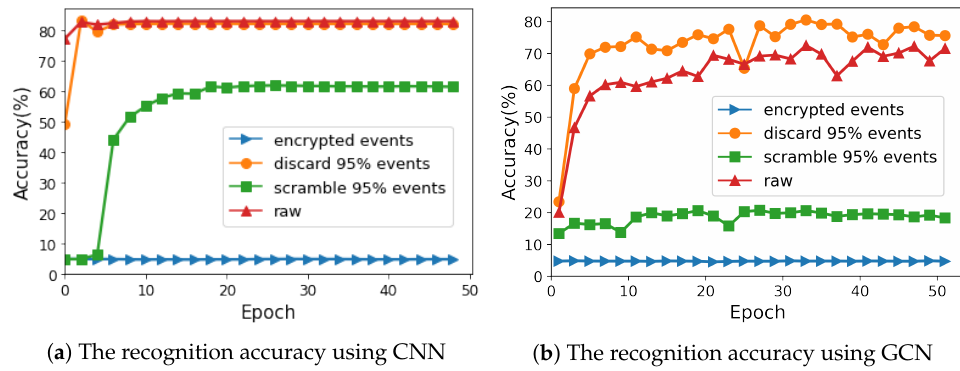
Figure 8. The accuracy of recognition attacks using event frame-based CNN and sparse event-based GCN under different